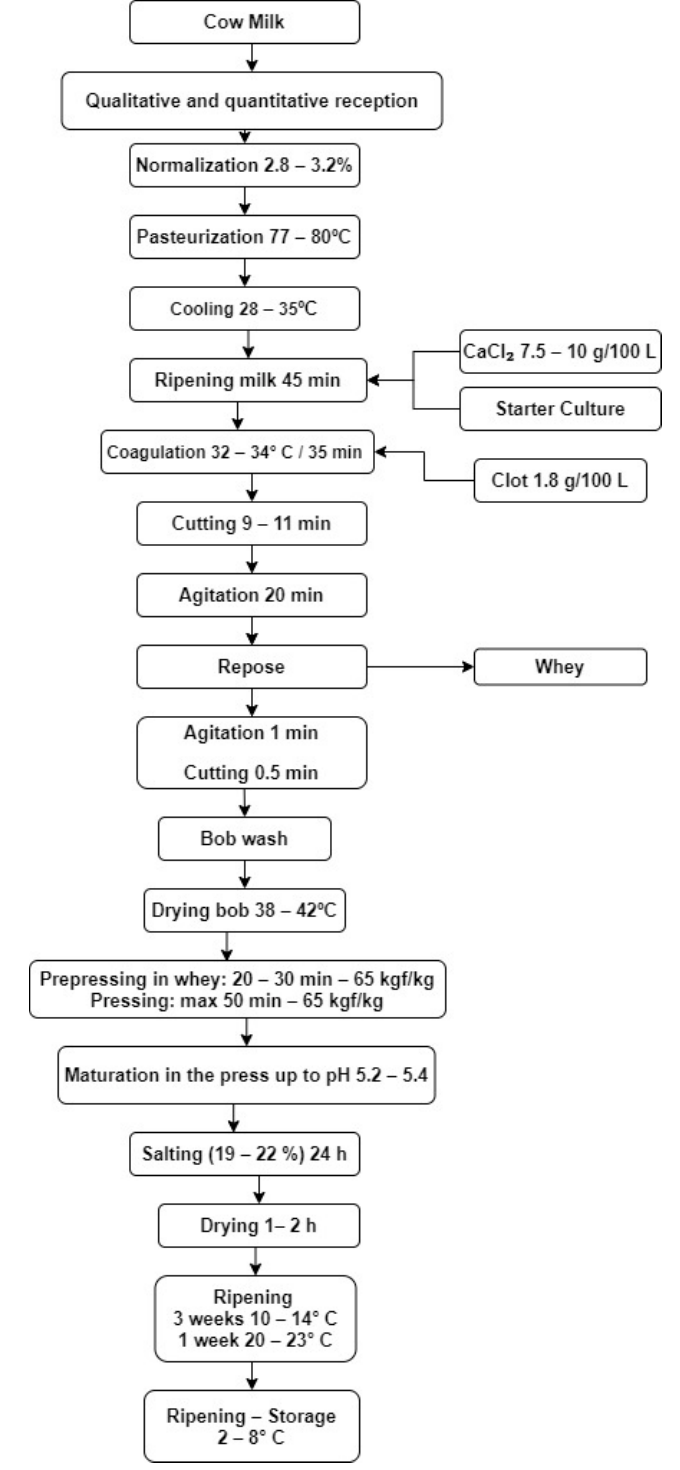
Figure 2. Flow diagram describing the technological steps of the Apuseni cheese.